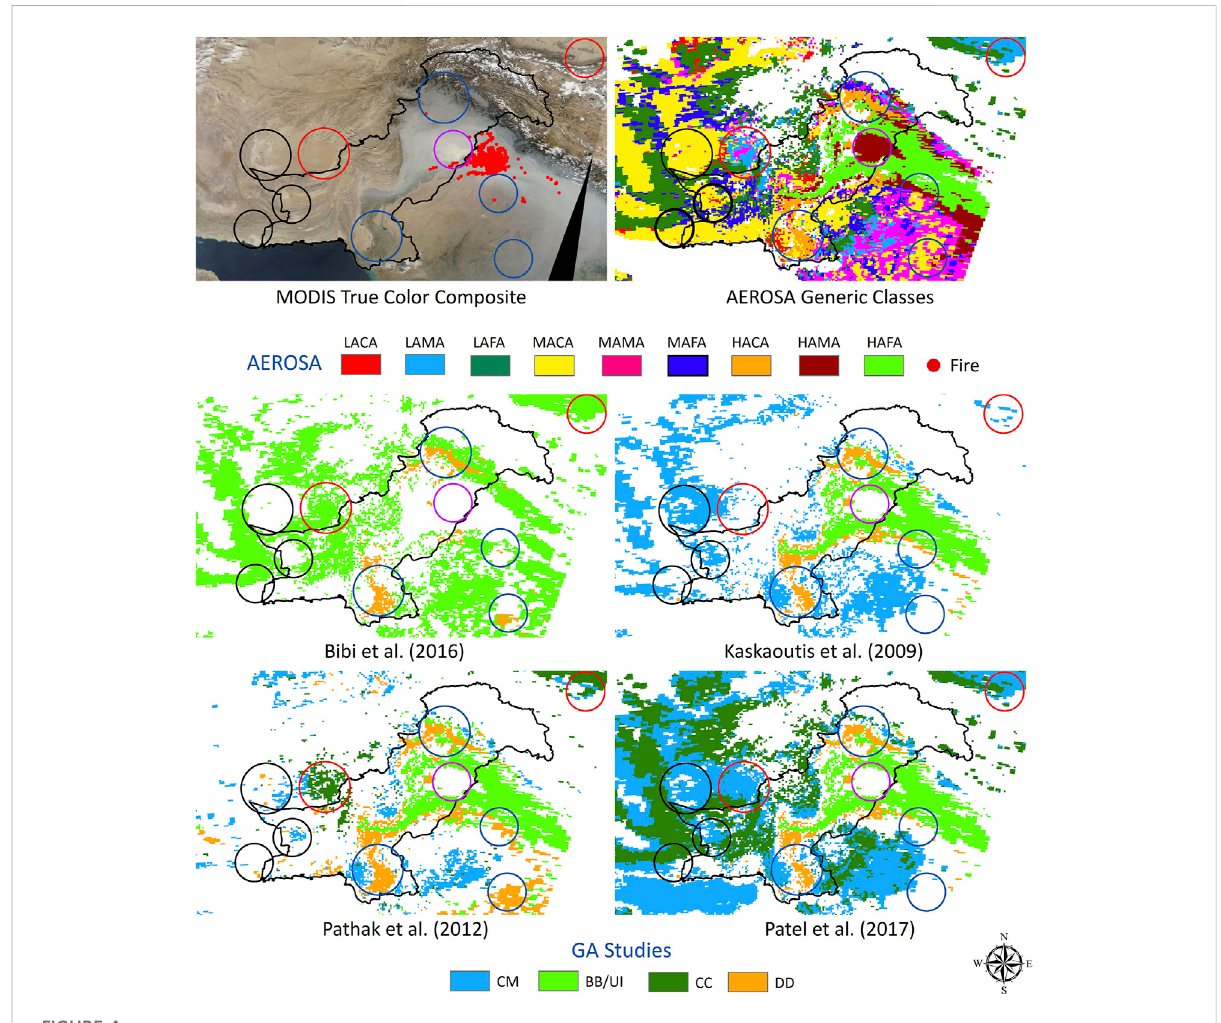
FIGURE 4 Same as Figure 3 but for an extreme smog event on 2 nd November